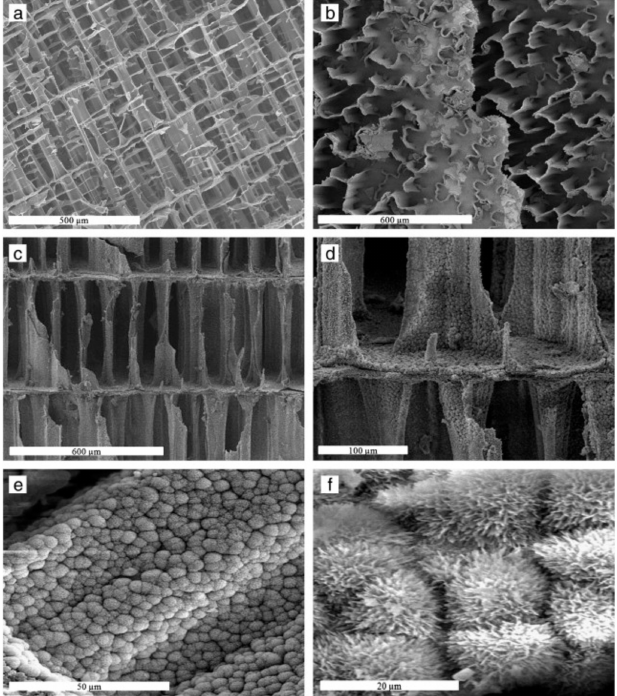
Figure 2. SEM images of cuttlefish bone ( a , b ) and cuttlefish bone after transformation into HAP ( c – f ). ( a ) Transverse cross-section ( b ) Pores formed by convoluted pillar ( c , d ) Transverse cross-section showing interconnected pores after transformation, ( e ) Aggregates of HAP and ( f ) dandelion-like structures. With permission from Elsevier https://doi.org/10.1016/j.msec.2013.09.036 (accessed on 19 May